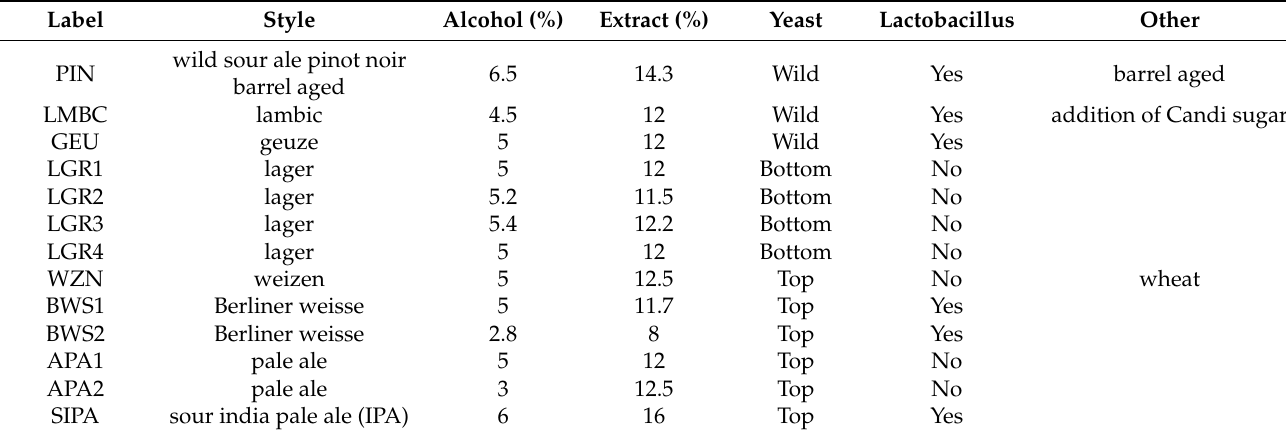
Table 1. Tested samples of commercially available